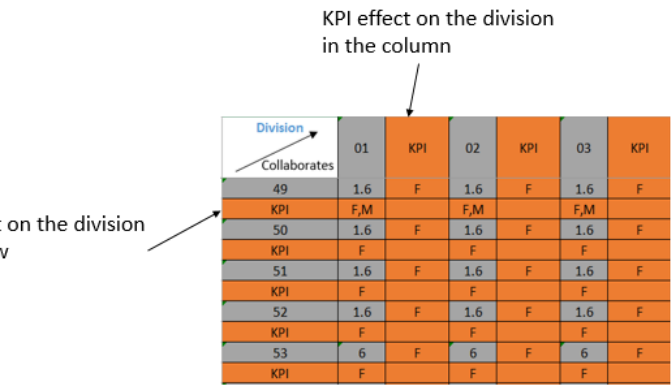
Figure 7. Example of the general matrix of